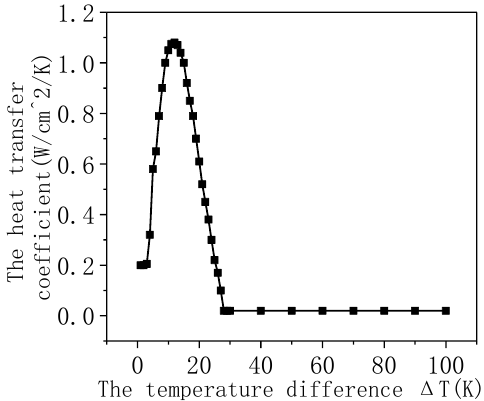
Figure 5. The heat transfer coefficient of LN2.